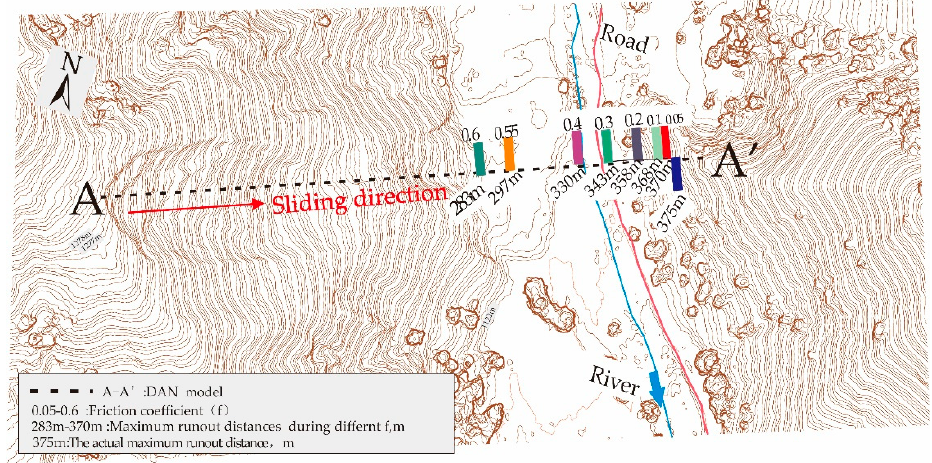
Figure 10. Variation trend of the moving speed versus the sliding rage of the sliding body under the action of different friction coefficients.